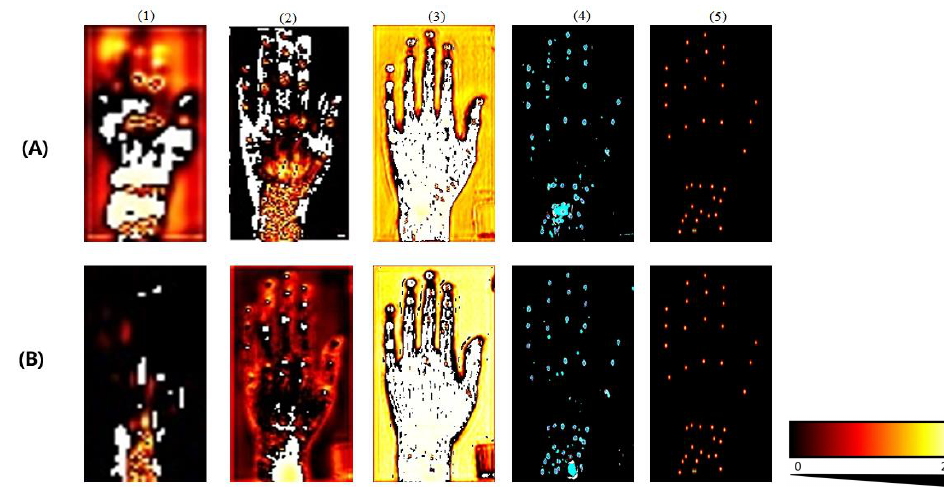
Figure 5. Feature map and output examples come from different models in the 2D hand radiograph dataset: row ( A ), SEG-UNet5; row ( B ), UNet5; columns ( 1 – 5 ) show the output of the up3 block, the up4 block, the final landmark detection heatmap, and ground truth, respectively. The RGB color value represents the amount of information contained in feature